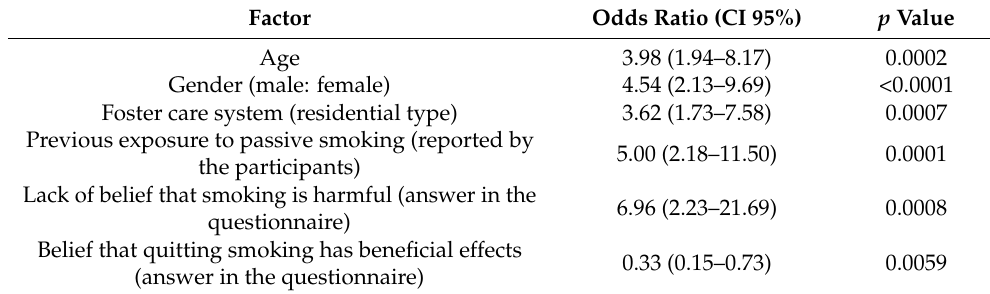
Table 2. Predictive factors for current smoker status in foster care teenagers (results of multivariate analysis).